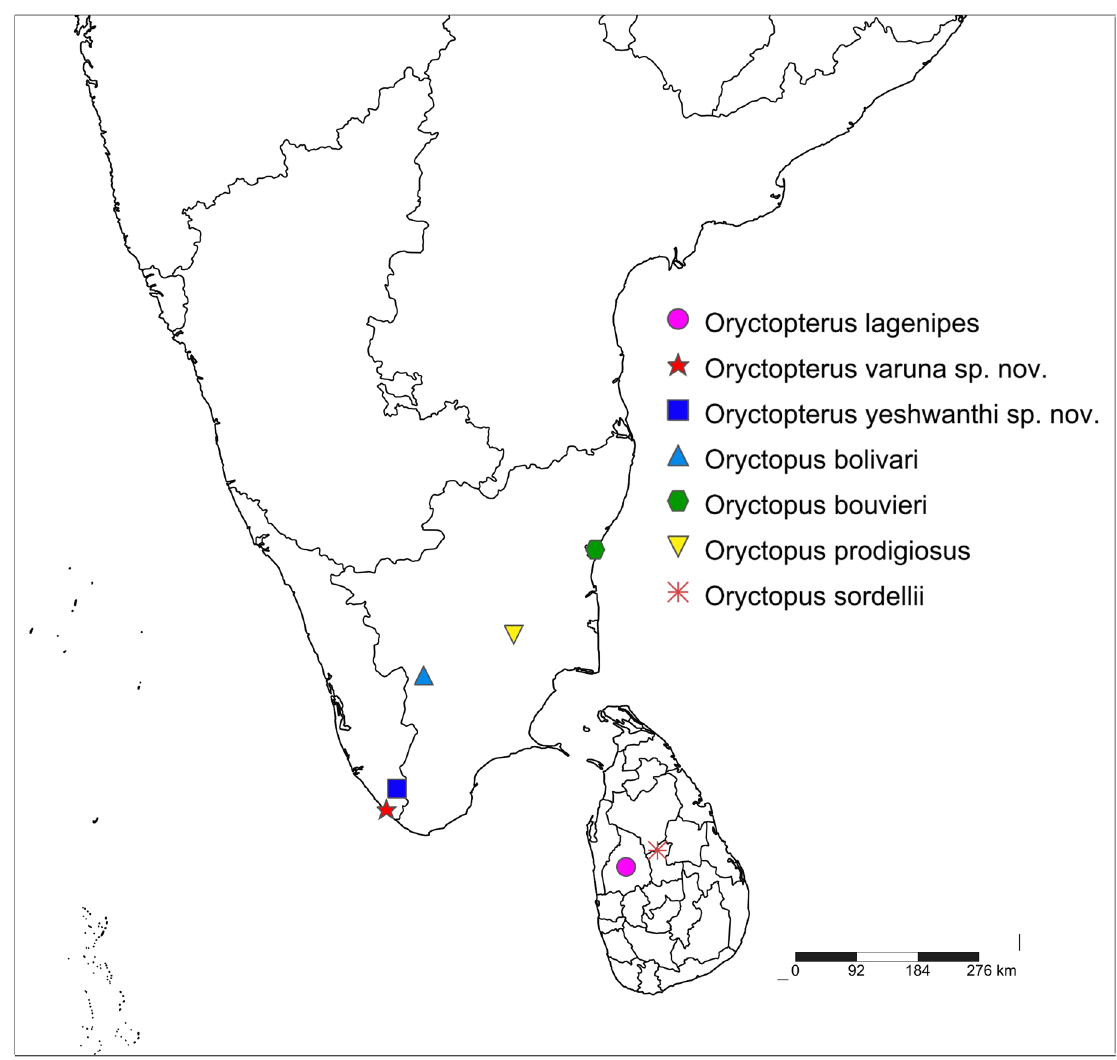
Fig. 70. Distribution of Oryctopinae Kevan, 1986